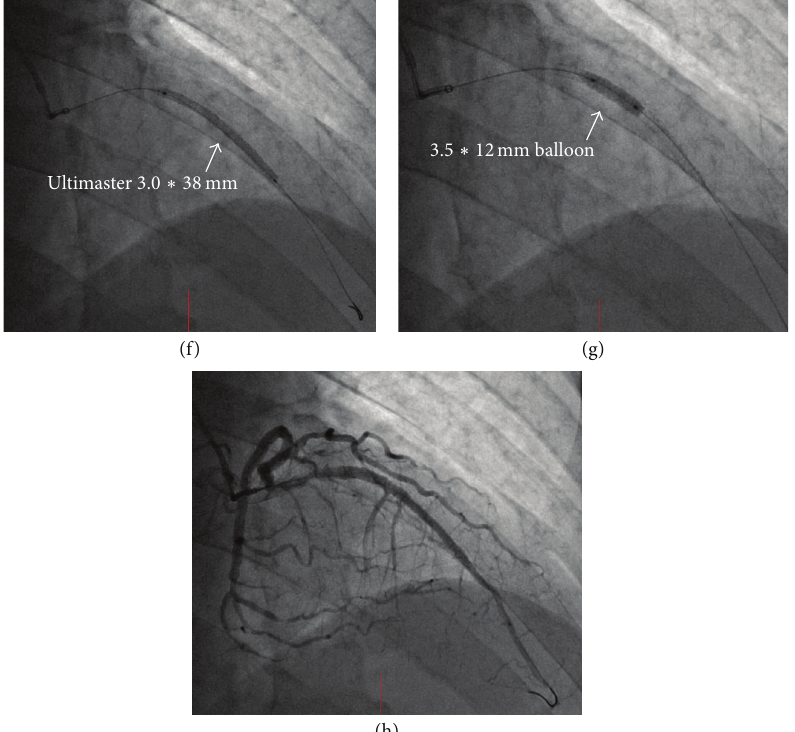
Figure2:(a)Wefailedtoengagethecoronarytrunkbyusinga6-FrAL-1guidingcatheter.Wethenengagedthecoronarytrunkbyusinga5-Fr diagnostic catheter, and a 0.014-inch guide wire was advanced across the LAD lesion. (b) Removing the 5-Fr diagnostic catheter, leaving only the guide wire. (c) A 1.5mm semicompliance balloon in the lead, along with a mother-child system, including a 6-Fr AL-1 guide catheter and a GuideLiner catheter, was advanced close to the orifice of the coronary trunk. (d) After anchoring it with a 1.5 mm balloon, the GuideLiner catheter was selectively introduced into the left coronary artery. In order to avoid coronary dissection, the contrast medium was gently introduced via manual injection. (e) Angiogram after dilatation with a 2.5 mm semicompliance balloon. Intravascular ultrasound (IVUS) images at the culprit lesion (i) and at the coronary ostium (ii). (f) Deploying a bioresorbable polymer sirolimus-eluting stent (Ultimaster (cid:2) 3.0 ∗ 38 mm). (g) Additional dilatation with a noncompliance balloon 3.5 ∗ 12 mm. (h) Final angiogram showing adequate dilatation of the culprit